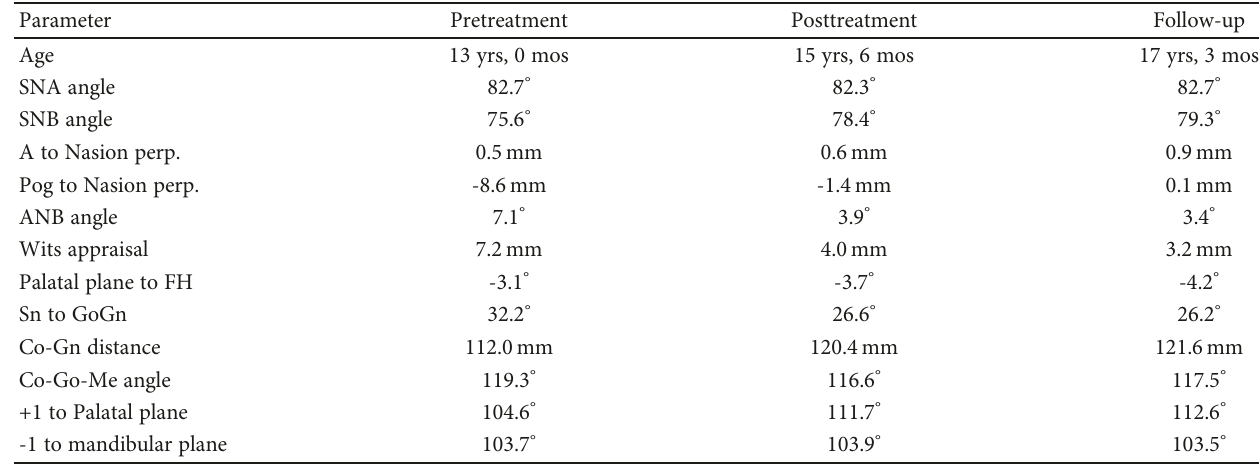
Figure 10: Case 3. 13-year-old male patient with skeletal Class II malocclusion, increased overjet, and overbite before treatment. Table 3: Cephalometric data of Case